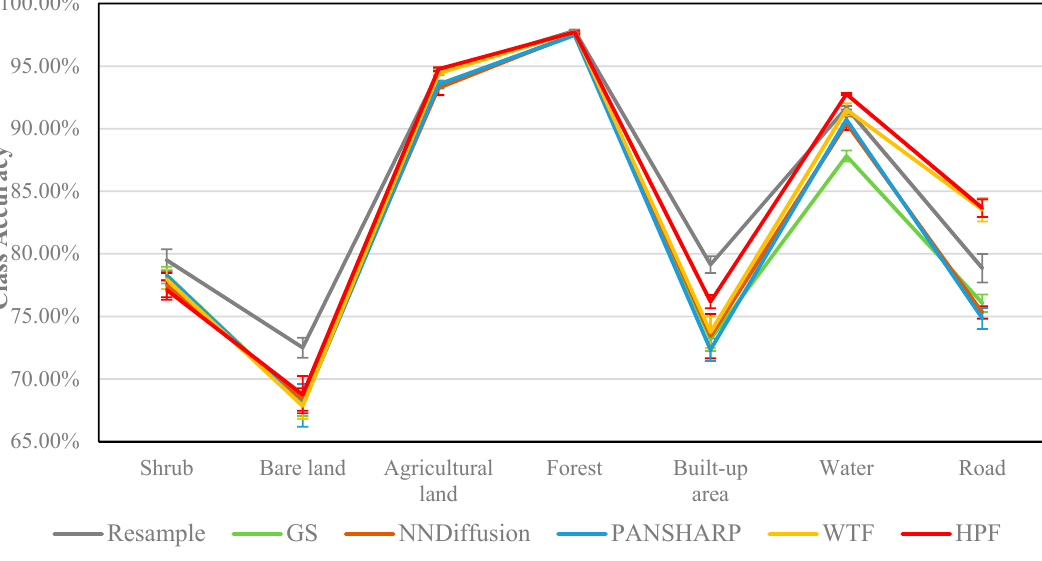
Figure 6. Class accuracy using data sets obtained by different downscaling methods.